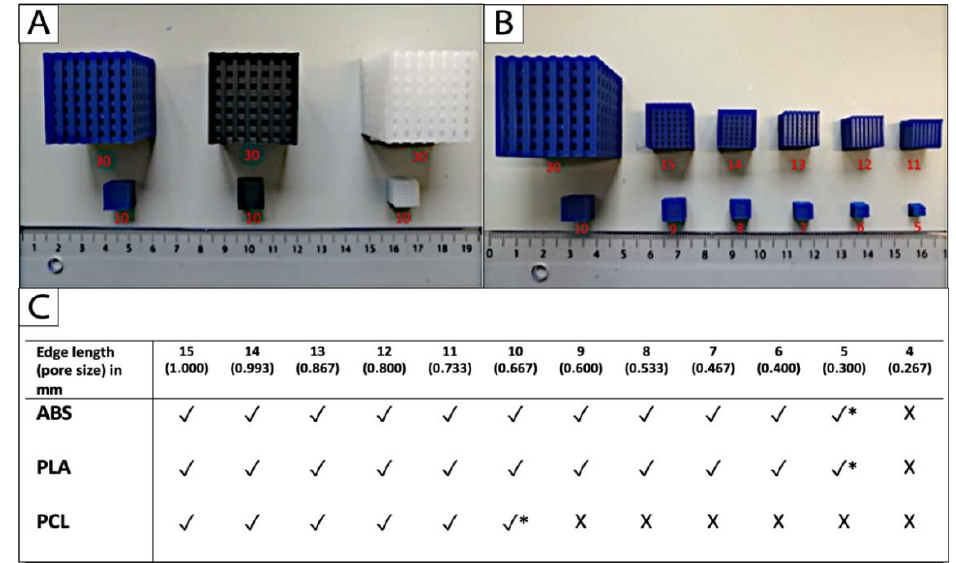
Figure 3. The printing limit (*) of ( A ) the filament materials ABS (blue), PLA (black), and PCL (white) was achieved ( B,C ) by uniform down scaling of the original scaffold, and defined as the smallest cube scaffold that could be fabricated appropriately without compromises in the micro- and macro-dimensional accuracy ( n = 5; *printing limit; √ fabrication possible; X fabrication impossible).